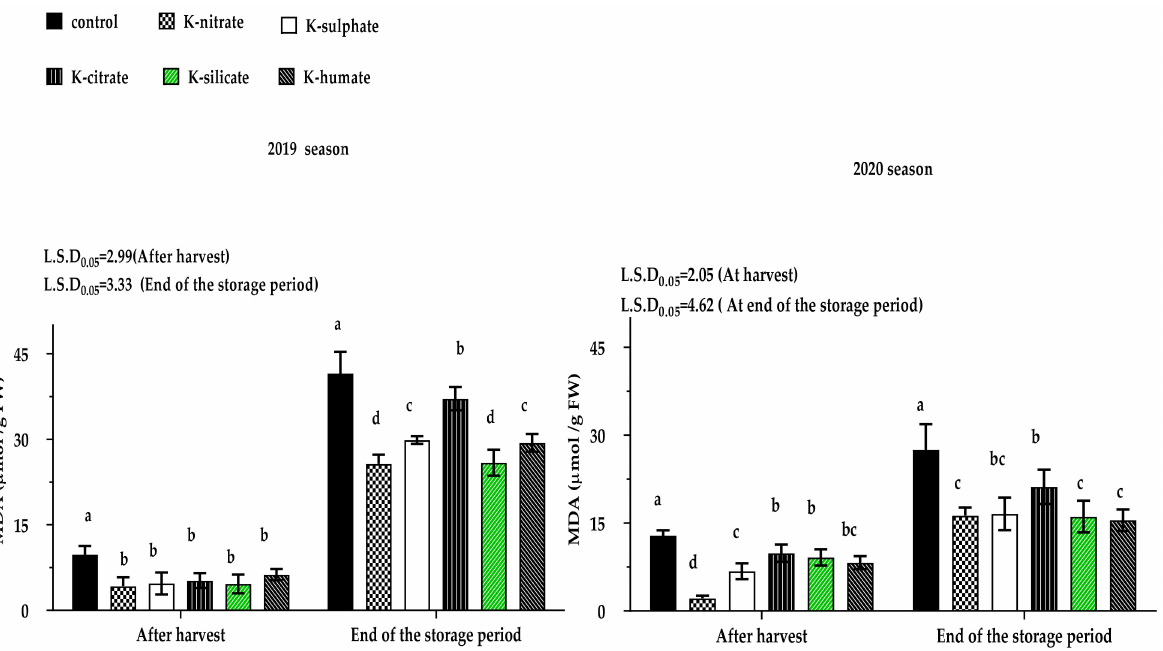
Figure 4. Effect of diverse potassium sources as foliar application on ‘Canino’ apricot fruit MDA content after harvest and at the end of storage period in 2019 and 2020 seasons. Data represent the mean with SD. Letters above each bar shown indicating significant differences among the tested treatment, if letters were same corresponding treatments are statistically equal and vice versa according to Duncan’s multiple range tests at p <